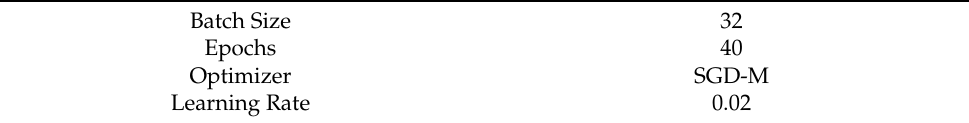
Table 3. Hyperparameters.